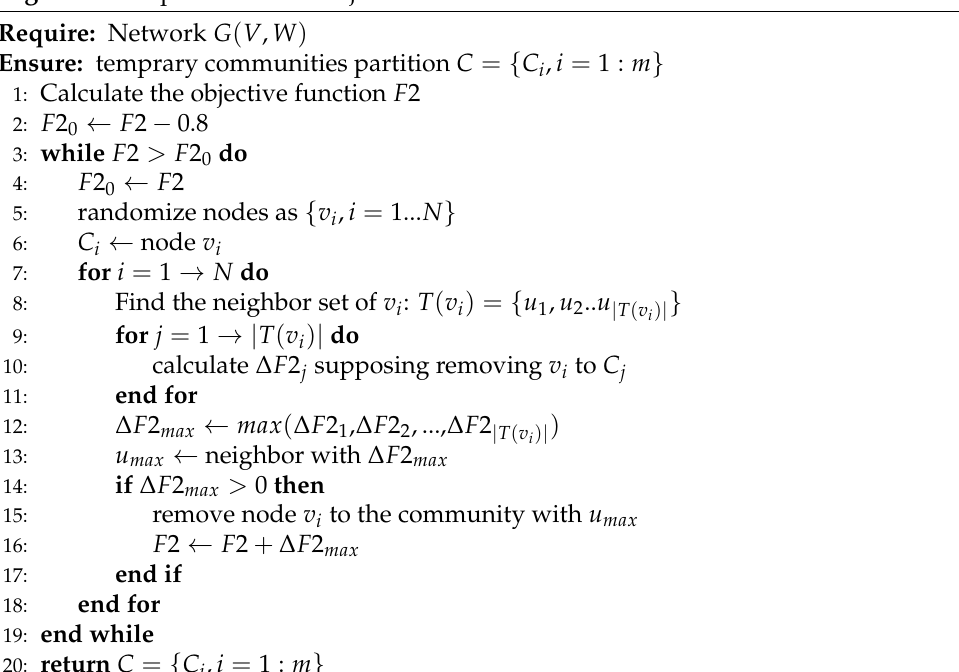
Algorithm 1 Optimization of objective function F